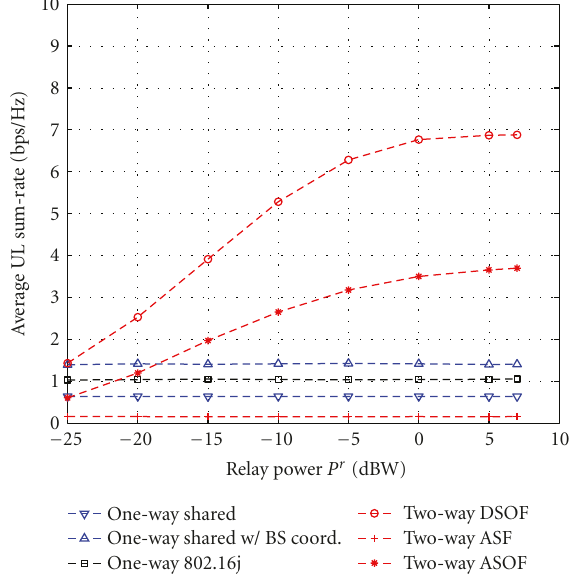
Figure 8: UL sum rate performance versus average relay transmit